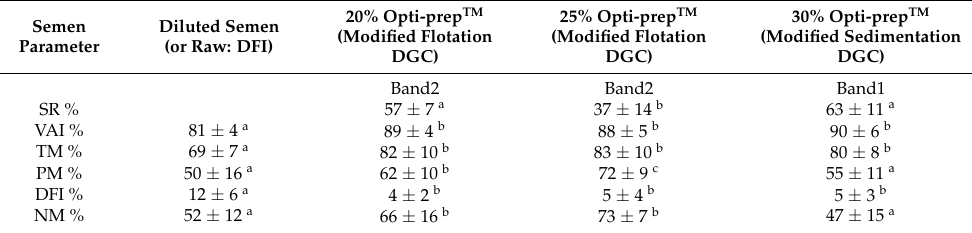
Table 3. Comparing the effects of different density gradient centrifugation (DGC) protocols on stallion sperm populations. The semen parameters include sperm recovery (SR), viability and acrosome intactness (VAI), total motility (TM), progressive motility (PM), DNA fragmentation index (DFI) and normal morphology (NM) before and after centrifugation by the modified sedimentation DGC (Band1 with 30% Opti-prep TM ) and modified flotation methods of DGC (Band2 with 20% and 25% Opti-prep TM ). Different letters indicate significant differences ( p ≤ 0.05, n = 7 stallions).